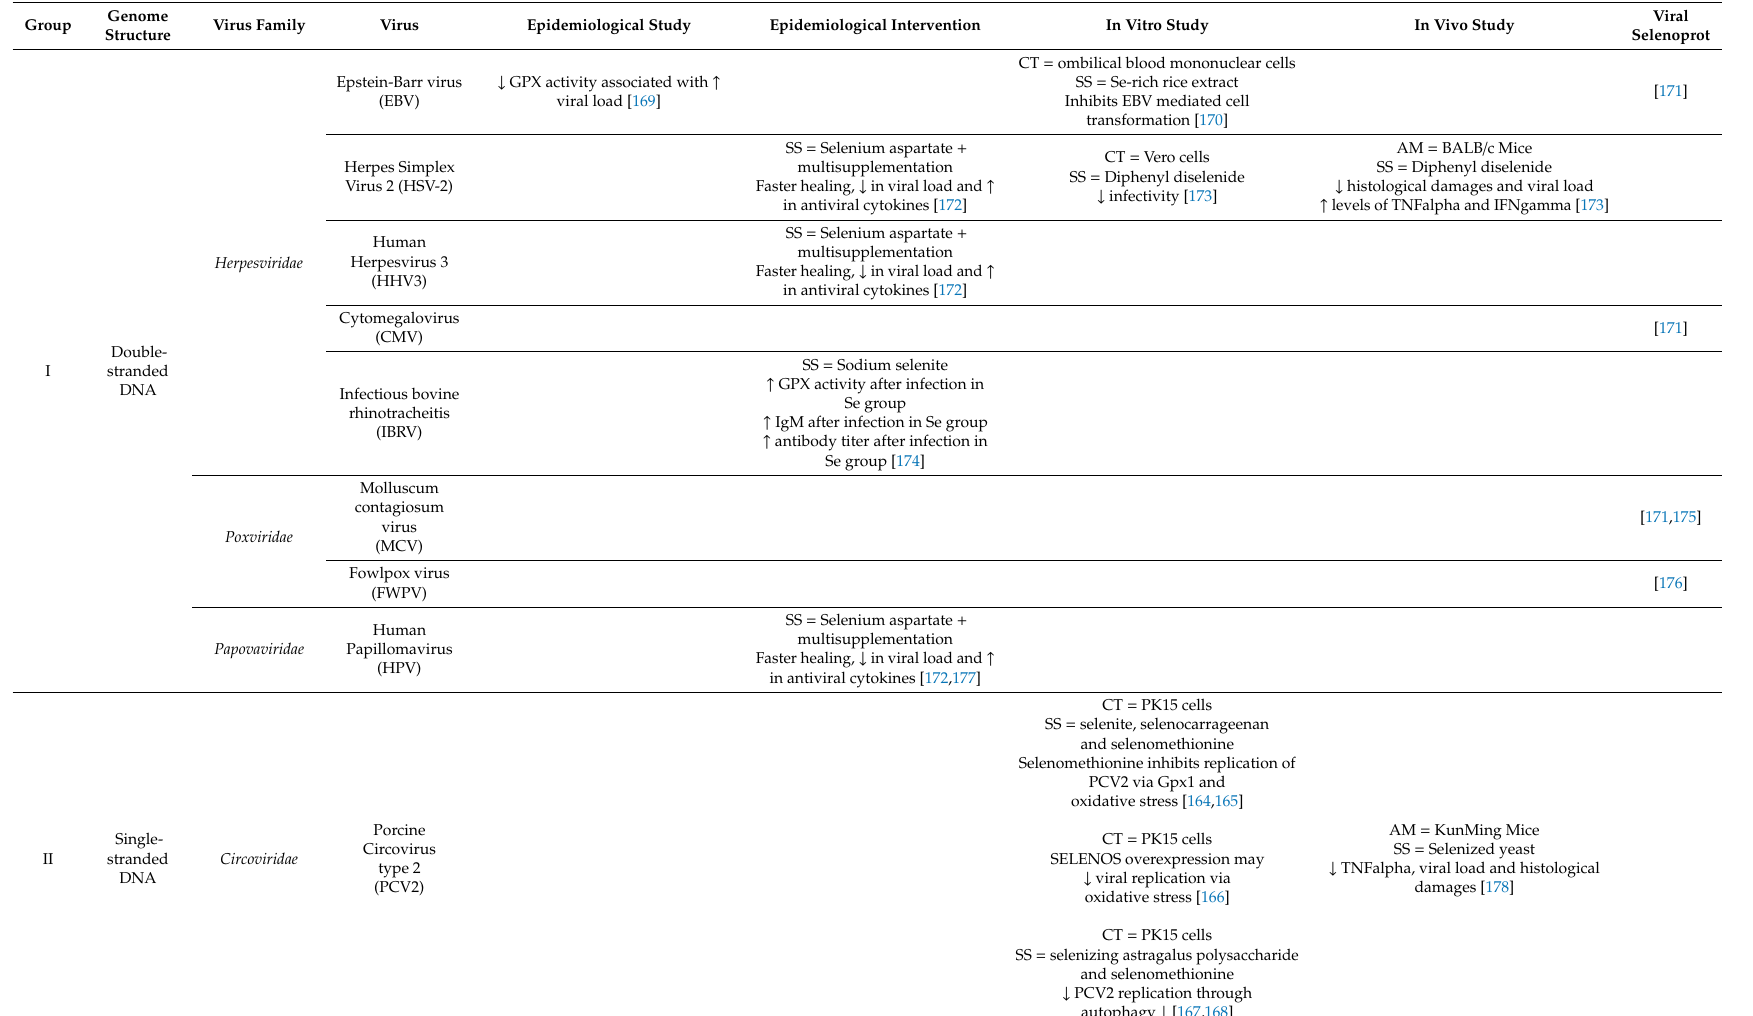
Table 1. Scientific literature available on the link between selenium, selenoprotein and viral infections listed as a function of Baltimore classification.